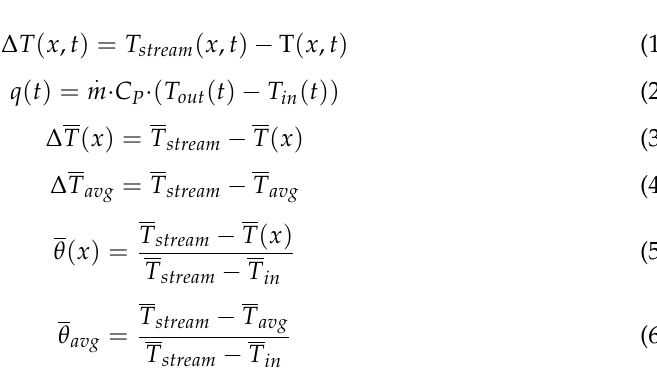
Figure 7. Heat exchanger inlet and outlet temperatures, and the corresponding instantaneous heat transfer rates for Test Condition 3. Error! Reference source not found. shows the effects of the enclosure configurations on the average degree of cooling and heat transfer. Error! Reference source not found. a compares the dimensionless, average temperature difference ( 𝜃̅ (cid:3028)(cid:3049)(cid:3034) ) versus the corre ‐ sponding average heat transfer per dimensionless degree of cooling ( q/ 𝜃̅ (cid:3028)(cid:3049)(cid:3034) ) for each test condition. Error! Reference source not found. b provides the corresponding values for the dimensional versions of these metrics ( ∆𝑇(cid:3364) (cid:3028)(cid:3049)(cid:3034) and q/ ∆𝑇(cid:3364) (cid:3028)(cid:3049)(cid:3034) ). For Test Condition 1, using only the base enclosure, the dimensionless, average temperature difference is 0.069, which is significantly smaller than other test conditions. Additionally, the average heat transfer required per dimensionless, average temperature difference is significantly higher (9.28 kW / 𝜃̅ (cid:3028)(cid:3049)(cid:3034) ). Error! Reference source not found. b also confirms that with the base enclosure the absolute temperature difference is small (0.13 °C) and the required heat transfer is high (5.10 kW/°C). As such, it can be hypothesized that the base enclosure (Test Condition 1) allows for significant water exchange and mixing with the warmer free stream. As a result, the average temperature inside the enclosure remains very close to the free stream tem ‐ perature. Utilizing a panel (Test Condition 2) or an extension (Test Condition 3) results in a similar dimensionless, average temperature difference (0.26 vs. 0.31) and average heat transfer required per dimensionless cooling effect (1.92 vs. 1.68 kW / 𝜃̅ (cid:3028)(cid:3049)(cid:3034) ), with the exten ‐ sion having a slightly better impact. But both are a significant improvement over the base enclosure. Compared to the base enclosure, the dimensionless temperature difference is